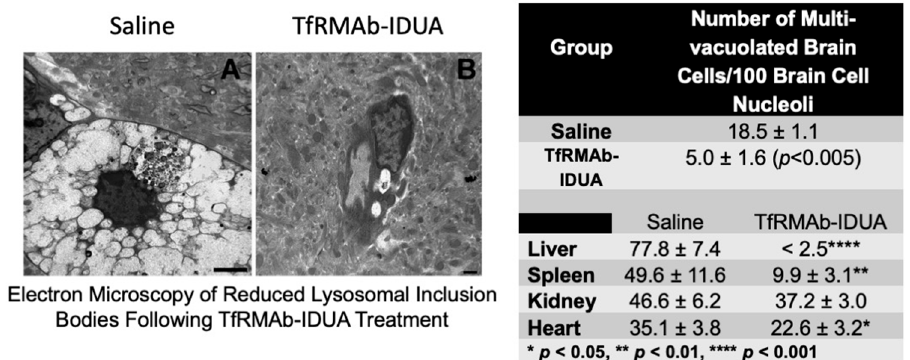
Figure 4. Reversal of lysosomal storage in brain of adult MPSI mice with IV injections of mouse TfRMAb-IDUA fusion protein. Six-month-old MPSI mice were treated with 1 mg/kg BW TfRMAb- IDUA IV twice weekly for 8 weeks. Electron microscopy showed a marked reduction in lysosomal inclusion bodies in animals treated with brain-penetrating IDUA fusion protein ( B ) compared with saline ( A ), resulting in a 73% reduction in brain lysosomal inclusion bodies ( right top ). The admin- istration of the TfRMAb-IDUA produced a marked reduction in glycosaminoglycans (GAG) in the peripheral organs ( right bottom ) that was comparable to that reported for the recombinant IDUA. The data (means ± SE) are terminal organ assays at the end of the 8-week study of MPSI mice